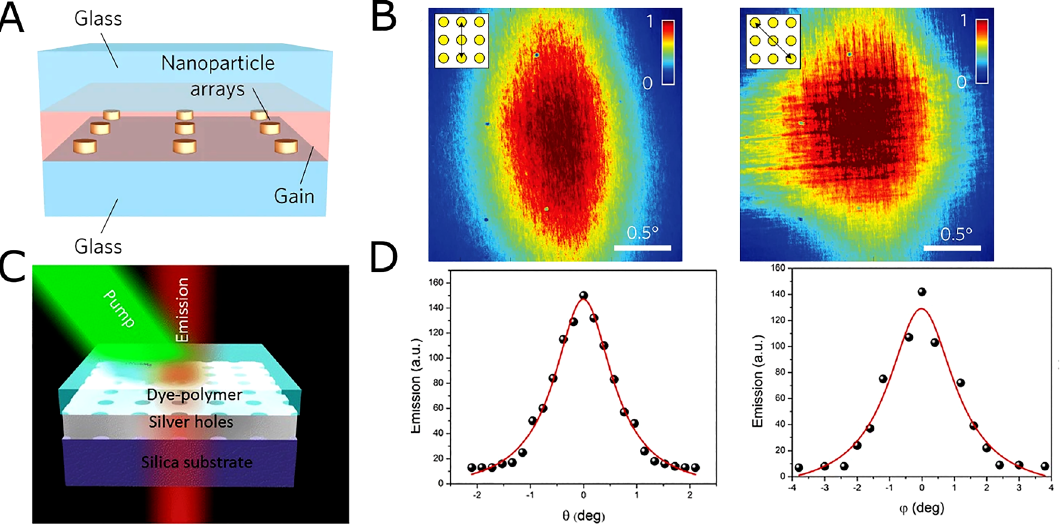
Figure 8: Directional